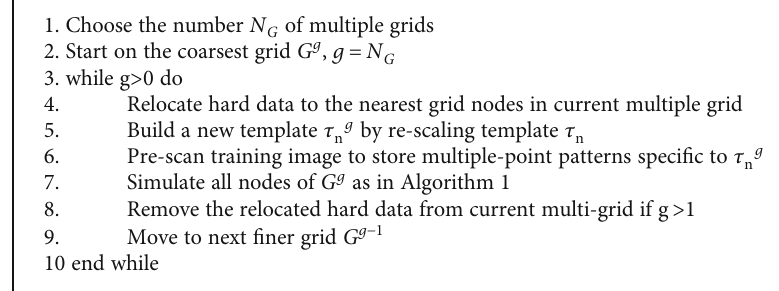
Algorithm 2: Multiple-point statistics simulation of multiple grids